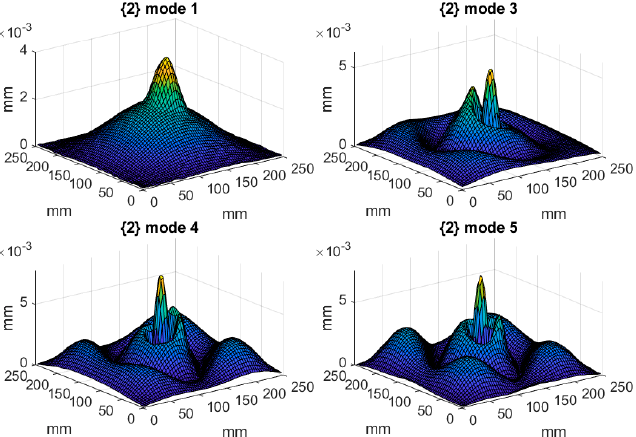
Figure 5. The considered mode shapes for the plate with a full local lack of the core.